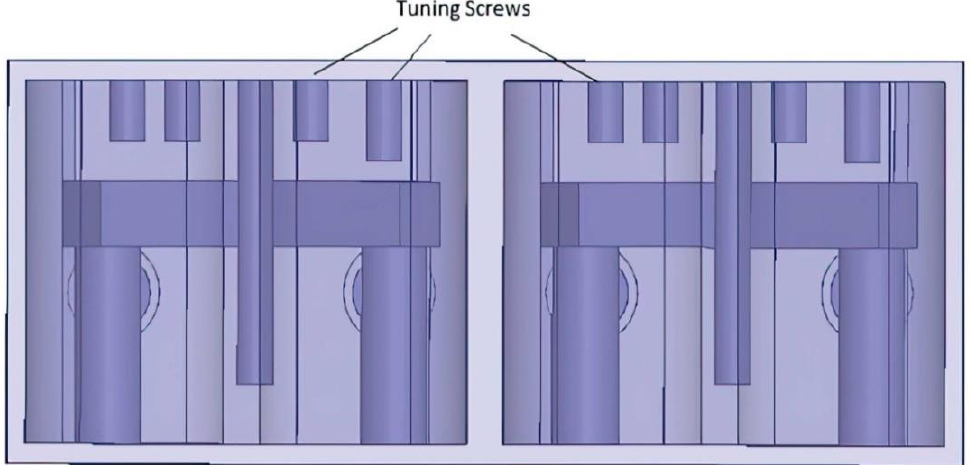
Figure 9. Proposed quadruple-mode band pass filter including tap feeders.